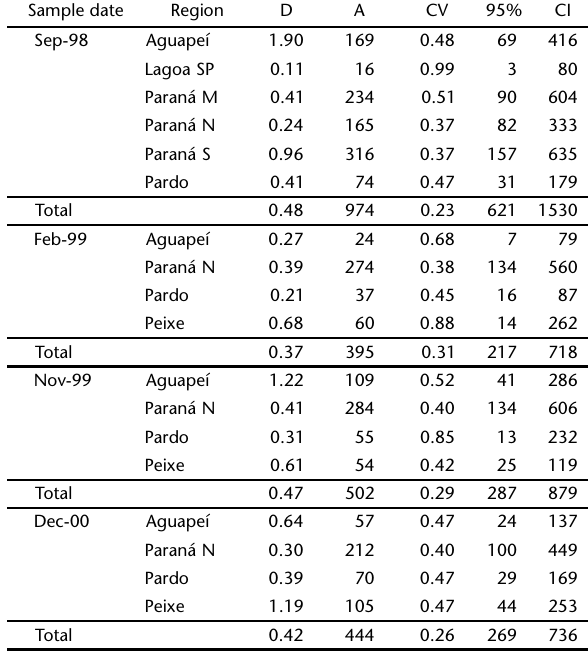
Table IV. Marsh deer abundance estimates by year for the different survey areas.